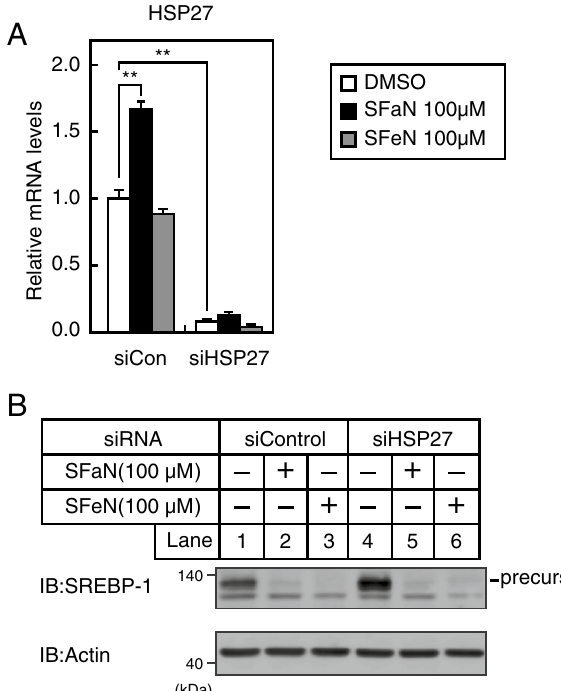
Figure 7. SFaN-mediated SREBP precursor degradation occurs HSP27-independently. ( A , B ) Huh-7 cells were transfected with 24 pmol of siRNA (siCon) or HSP27 siRNA and incubated in medium B for 48 h. The cells were then shifted into medium B in the presence of the vehicle, 100 μM SFaN or SFeN for 6 h. Total RNA was isolated from the cells. Real-time quantitative PCR was performed, and relative mRNA levels were obtained by normalization to GAPDH mRNA. All data are represented as the means ± S.E. (n = 3) ( A ). Whole-cell extracts underwent immunoblotting (IB) with anti-SREBP-1 (2A4) or anti-β-actin antibodies ( B ). All data are expressed as mean ± S.E. **, p < 0.01. Full-length images of all replicates are presented in Supplementary Fig. S7.